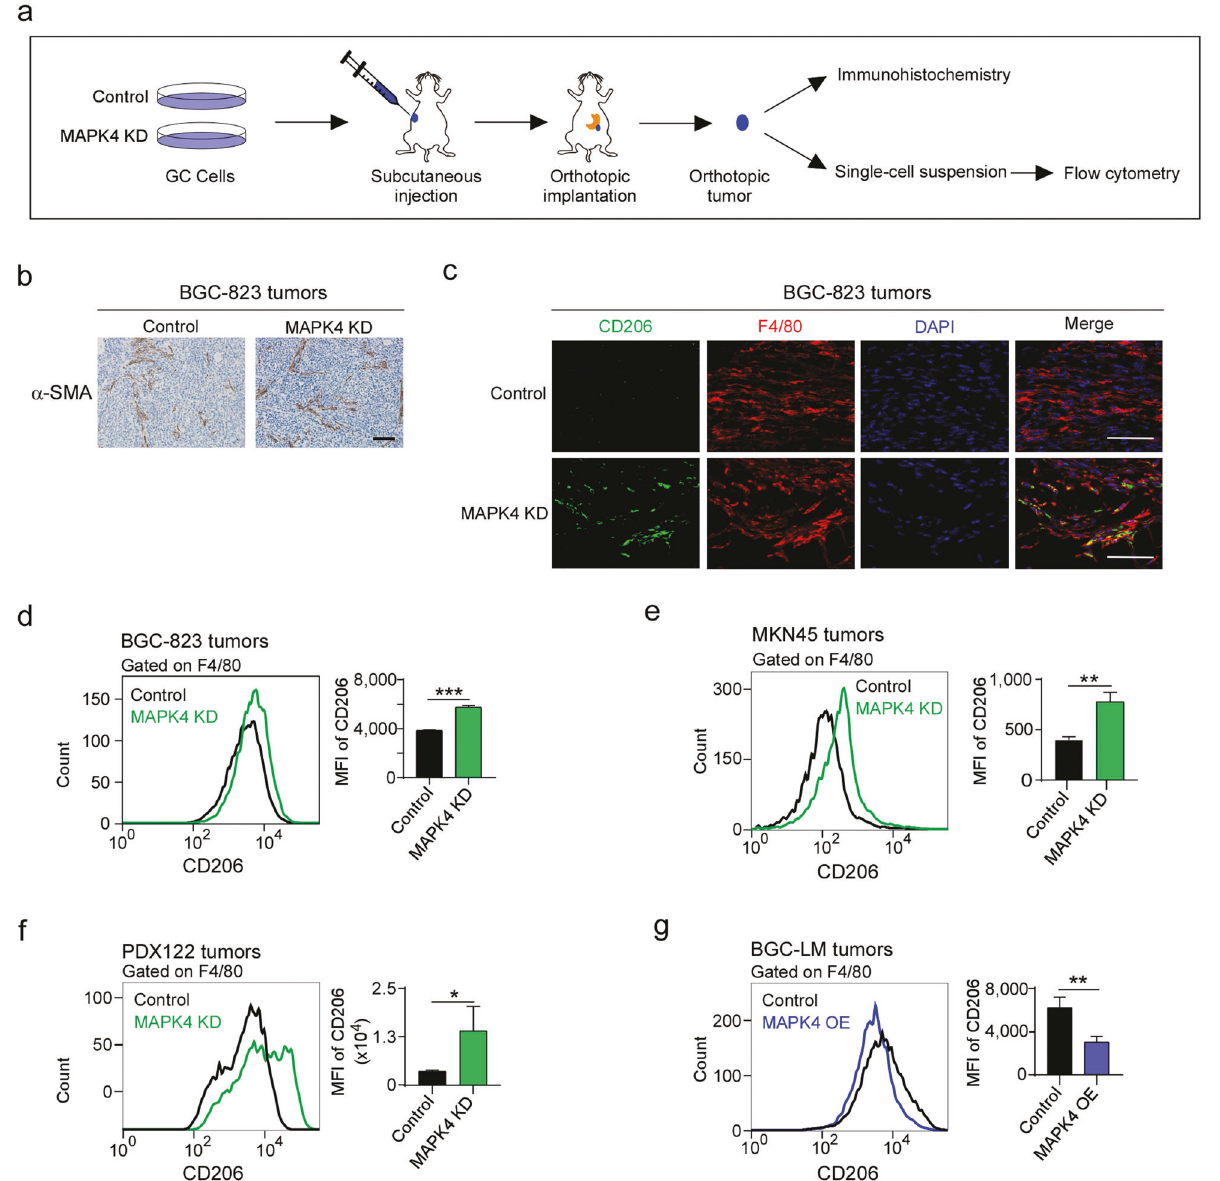
Fig. 3 MAPK4 downregulation in gastric cancer cells polarizes TAMs in orthotopic tumors. a Schematic representation of orthotopic gastric cancer tumors for immunohistochemistry or fl ow cytometry analysis. b Orthotopic tumors of MAPK4-depleted BGC-823 cells or controls were subjected to immunohistochemistry with anti- α -SMA antibody (brown). The nuclei were stained with hematoxylin (blue). Scale bars, 100 μ m. c Control and MAPK4-depleted BGC-823 cells were used for orthotopic implantation. Orthotopic tumors were further analyzed by immuno fl uorescence with anti-F4/80 (red) and CD206 (green) antibodies. The nuclei were stained with DAPI (blue). Scale bars, 50 μ m. d – f Single-cell suspensions were prepared from orthotopic tumors of BGC-823 ( d ), MKN45 ( e ) or PDX122 ( f ) cells depleted or not depleted of MAPK4 and analyzed by fl ow cytometry with anti-F4/80 and anti-CD206 antibodies. Quanti fi cation of CD206 expression in F4/80-positive cells is shown. MFI mean fl uorescence intensity. The gating of F4/80-positive cells is shown in Supplementary Fig. 4a – c. g Single-cell suspensions from orthotopic tumors of control and MAPK4-overexpressing BGC-LM cells were stained with F4/80 and CD206. CD206 expression in F4/80- positive cells was analyzed by fl ow cytometry. The gating of F4/80-positive cells is shown in Supplementary Fig. 4d. The data are expressed as the means ± standard deviations. * p < 0.05, ** p < 0.01, *** p < 0.001; NS, not signi fi cant (Student ’ s t